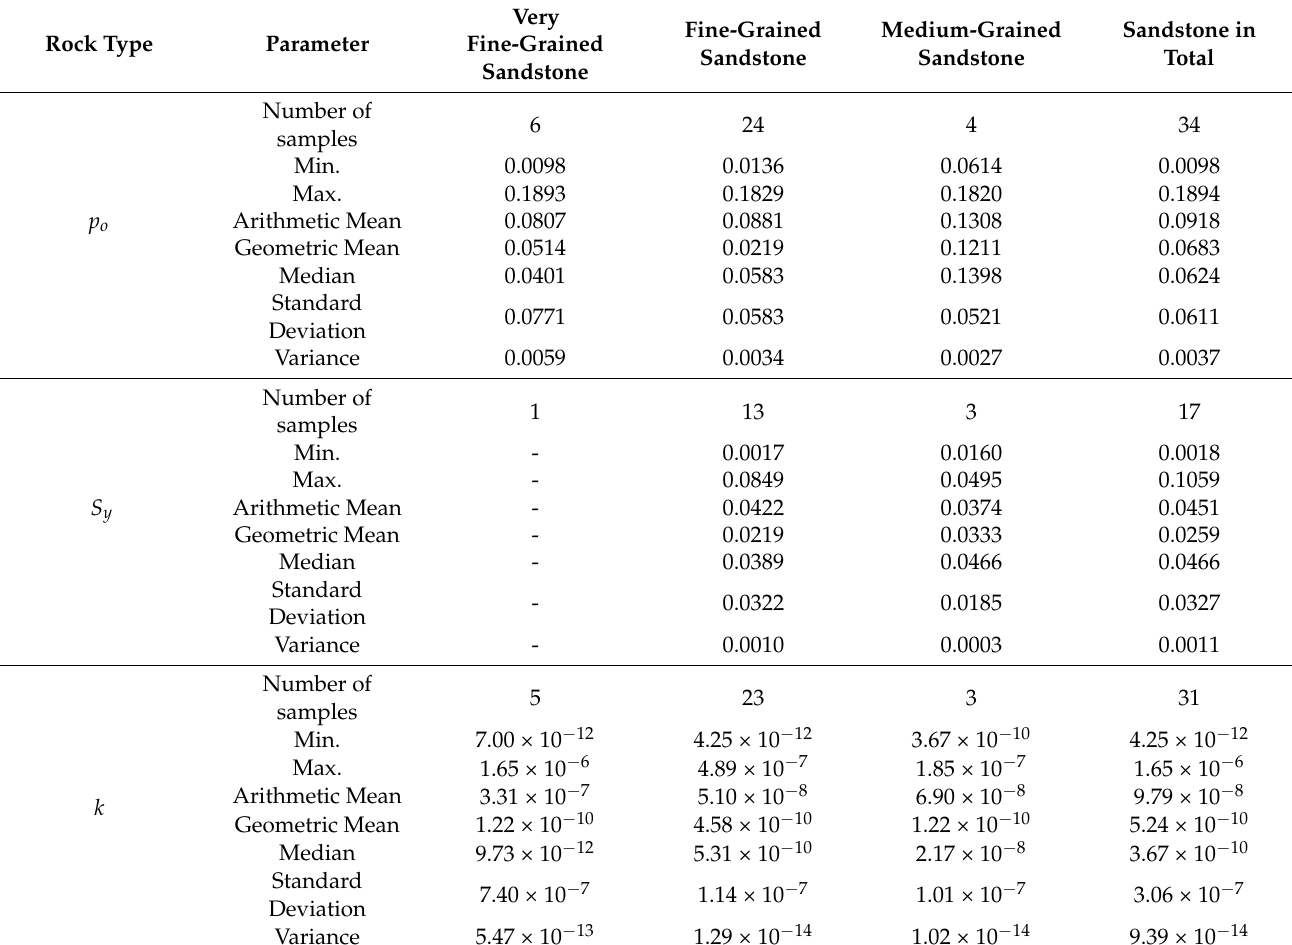
Table 2. Statistics of the measurement date